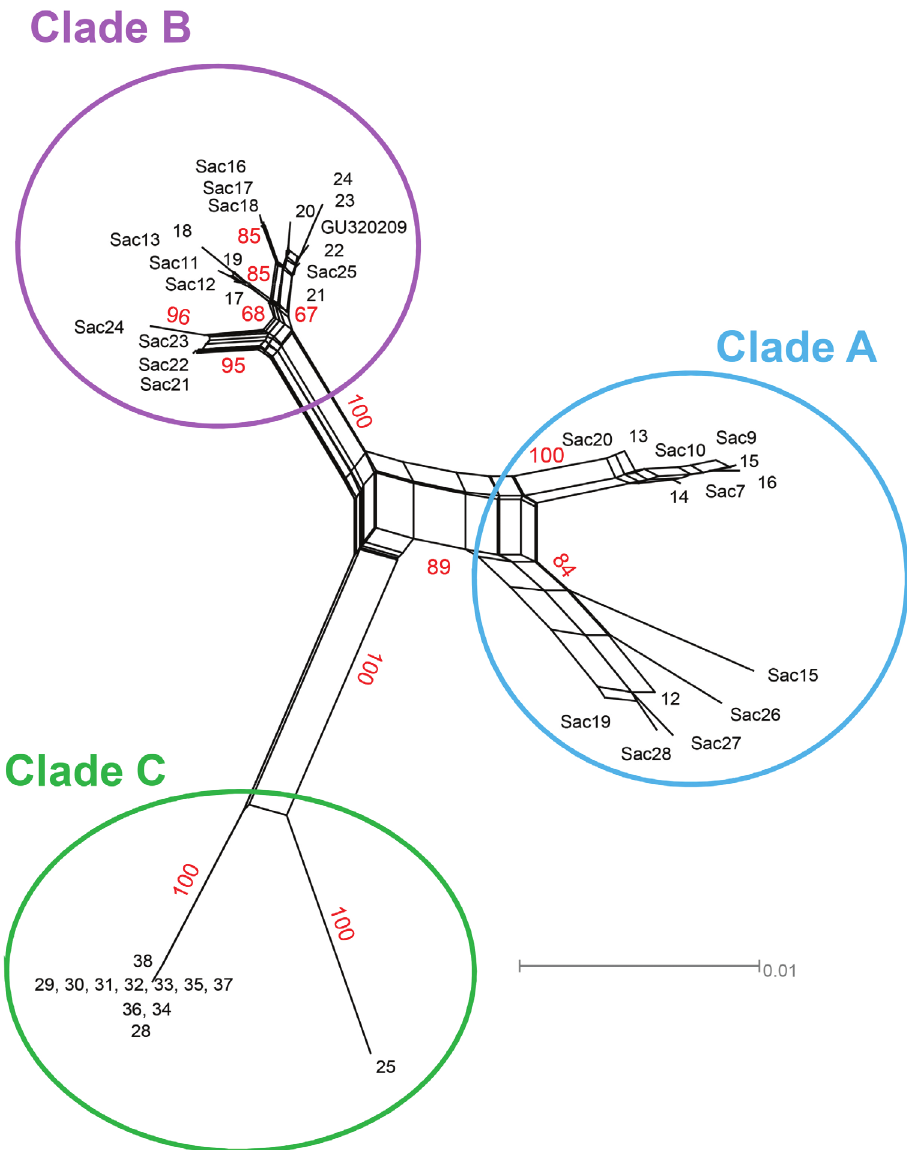
Figure 4. Split tree network, based on the complete mitochondrial cytochrome b gene. Red numbers at nodes are bootstrap values in